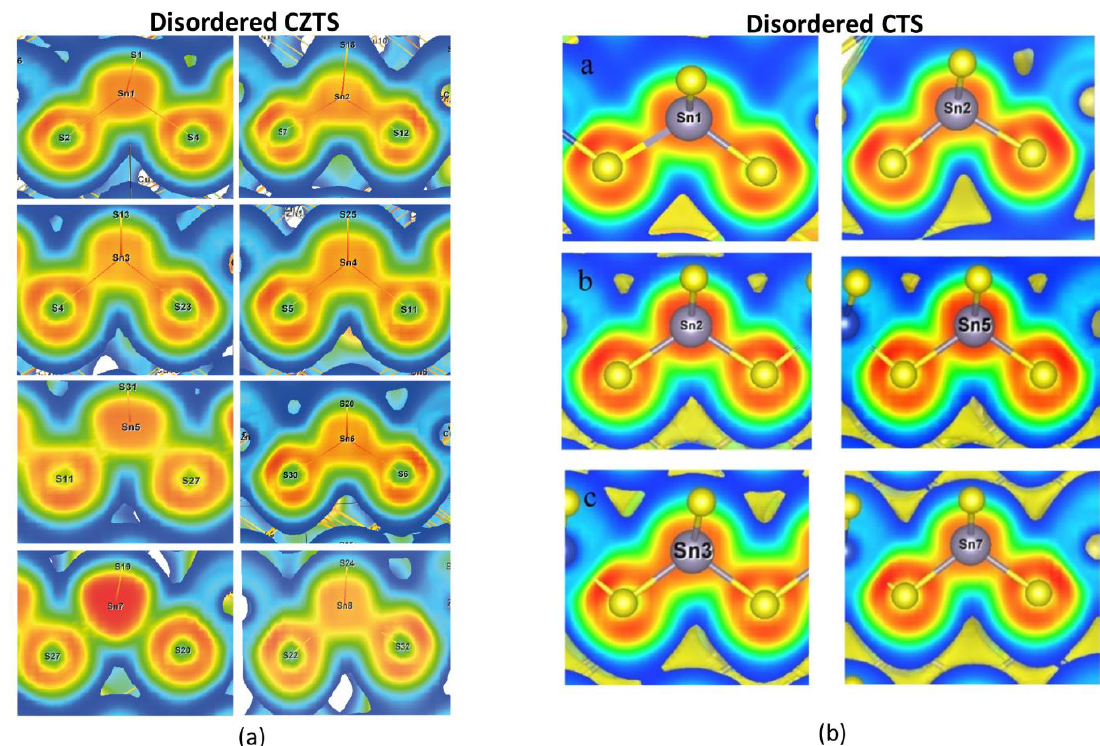
Figure 9. The calculated electron localization function mapped on to the Sn-S bonds in ( a ) disordered CZTS and ( b ) disordered CTS. The ELF distribution for certain Sn ions shows a strong bonding inhomogeneity in both systems, with only CZTS showing lone-pair localization in a fraction of ions (for example see Sn7 in the panel in the bottom left corner of the figure). These images are taken from [34,52].